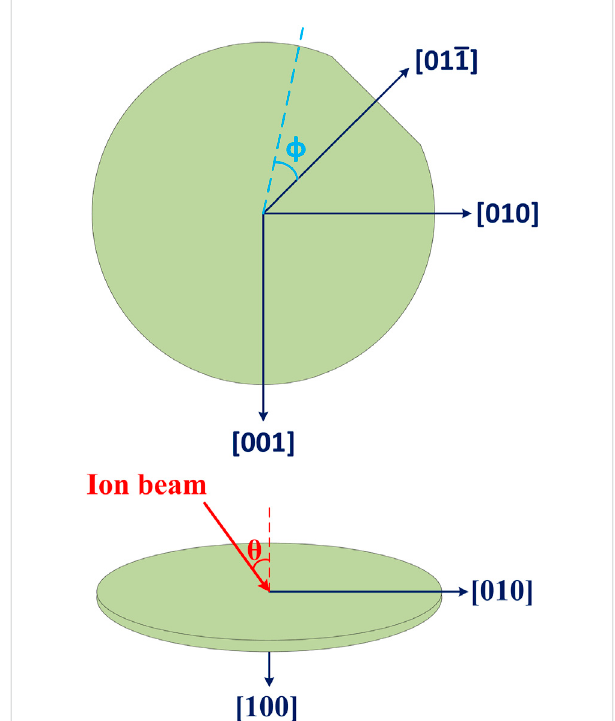
FIGURE 1 (A) Top-viewand (B) side-viewofSOIwaferdepictingorientation and different crystallographic axes used in this